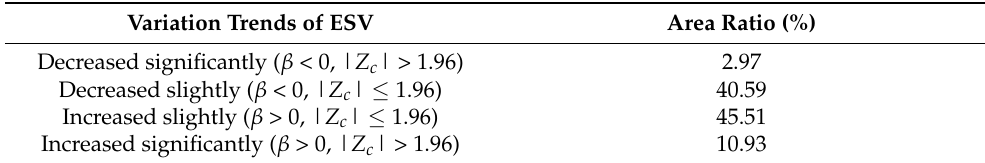
Table 6. Area ratio with different variation trends of grassland ESV in Inner Mongolia from 2000 to 2019.